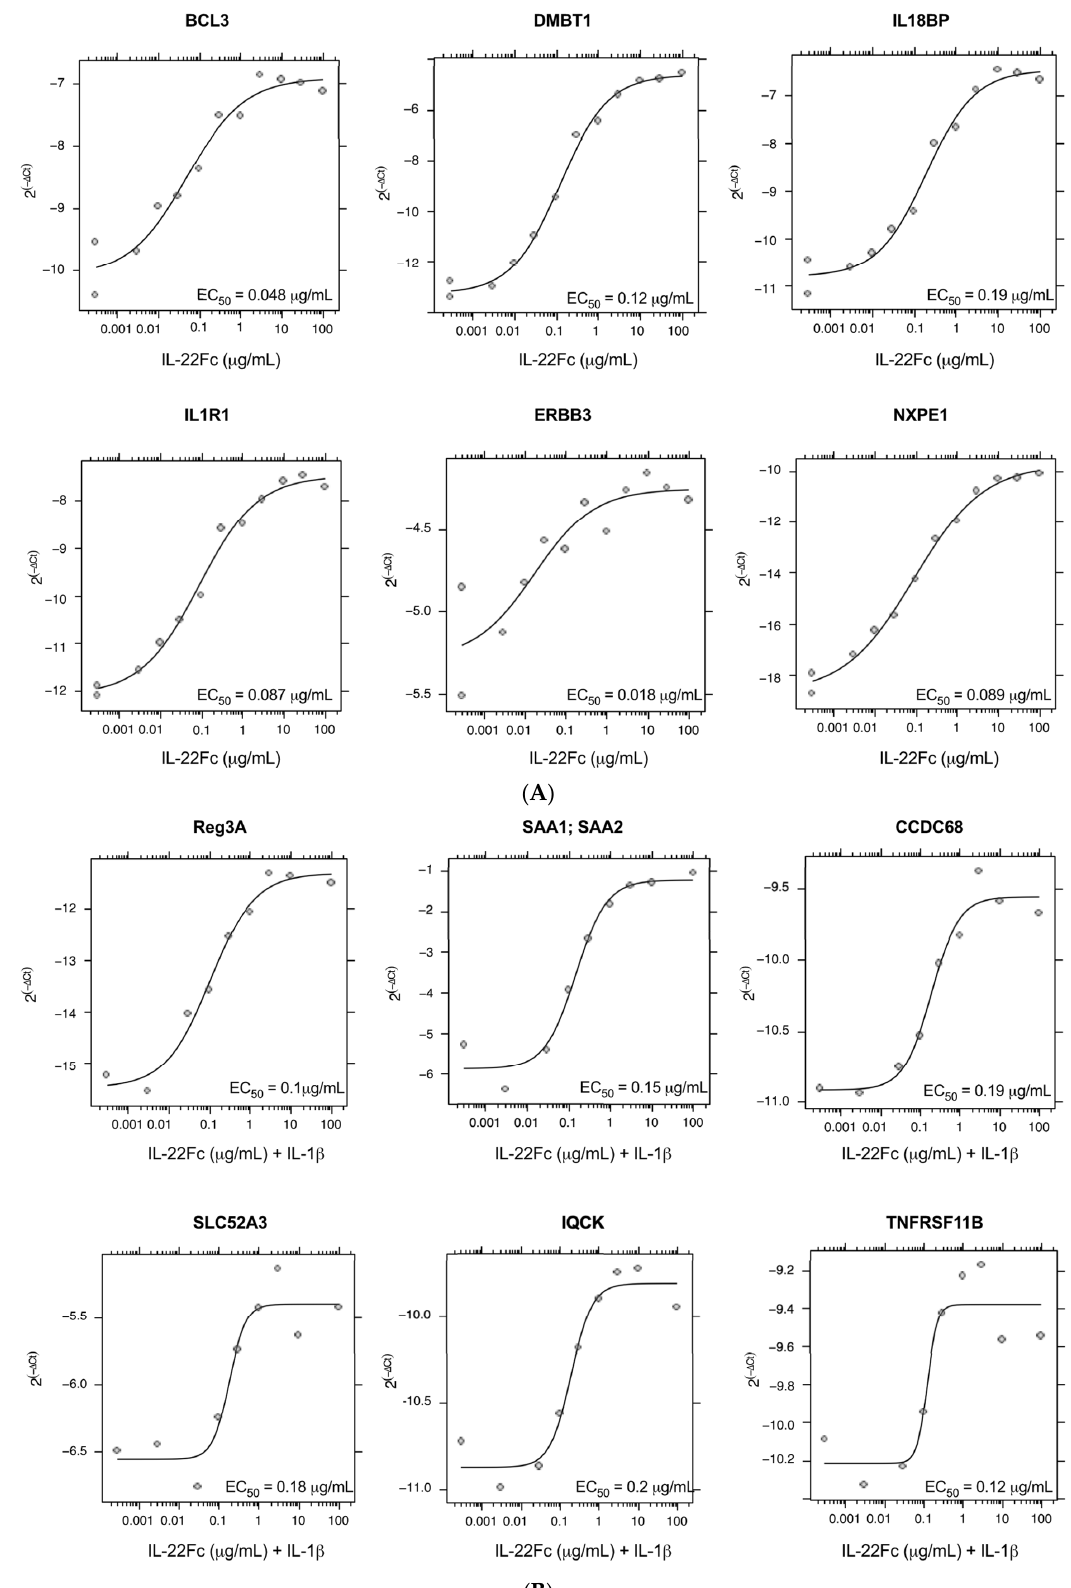
Figure 4. IL-22 dose-responsive genes. ( A ) Representative plots of the genes that were the most dose responsive to IL-22Fc. ( B ) Representative plots of the genes that were the most dose responsive to IL-22Fc+ IL-1 β